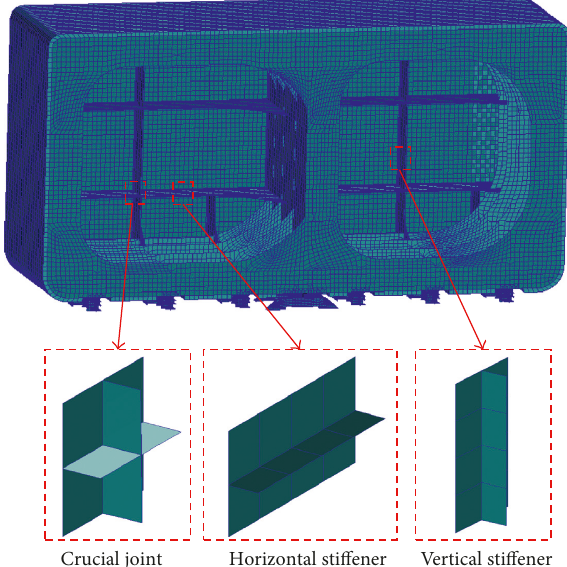
Figure 10: Typical structural joint of the LNG fuel